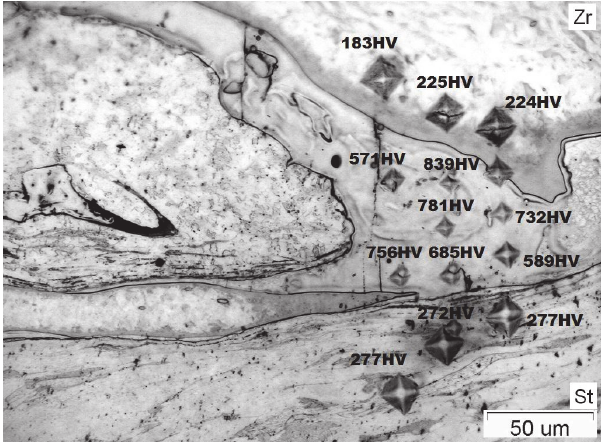
Figure 5: Joint microstructure of the zirconium-steel bimetal together with results of